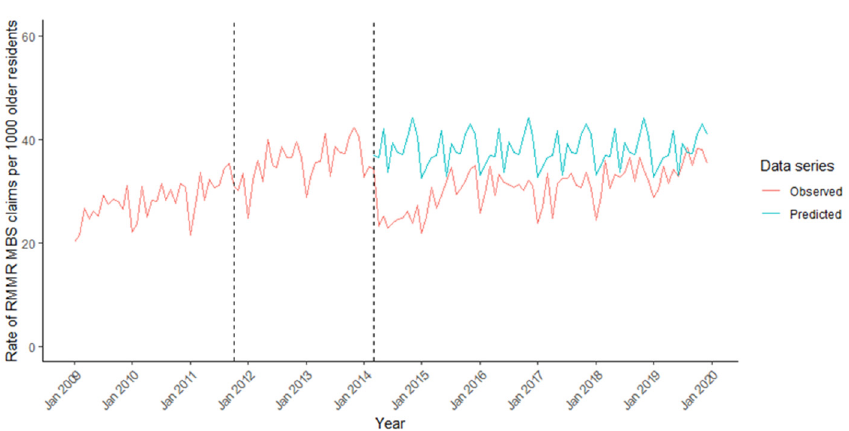
Figure 4. Monthly rate of GP claims for Residential Medication Management Reviews (RMMRs) per 1000 older residents of aged care facilities between 2009 and 2019, and counterfactual forecast in the absence of changes to program rules in 2014. Dashed lines indicate dates of program rule changes.